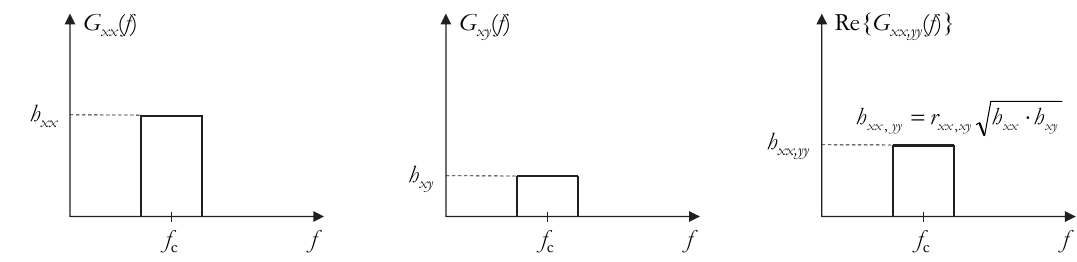
Figure 4: Example of one-sided auto- and cross-PSD for a tension-torsion loading with non-zero correlation r xx,xy (stress case 3). Combining the stress cases (1, 2, 3, 4) in Tab. 2 with the materials models (A, B, C) in Tab. 3 results in the whole set of load cases (1A, 2A, 3B, …) in Tab. 4, which are examined in the numerical examples.